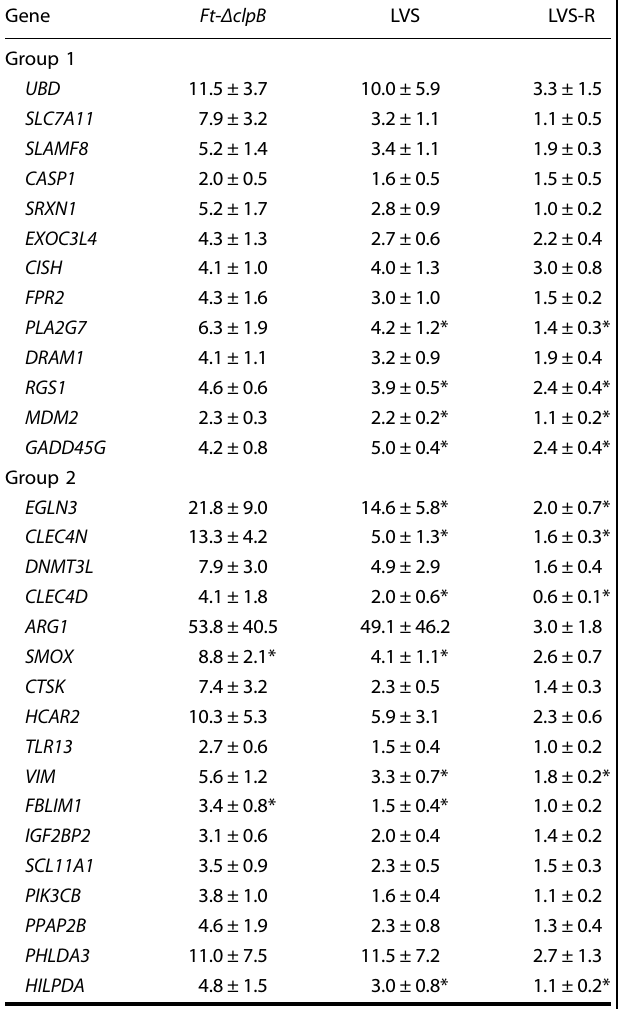
Table 2. Relative gene expression of novel factors that correlate with protection in PBLs of C57BL/6 mice recovered from co-cultures at 48